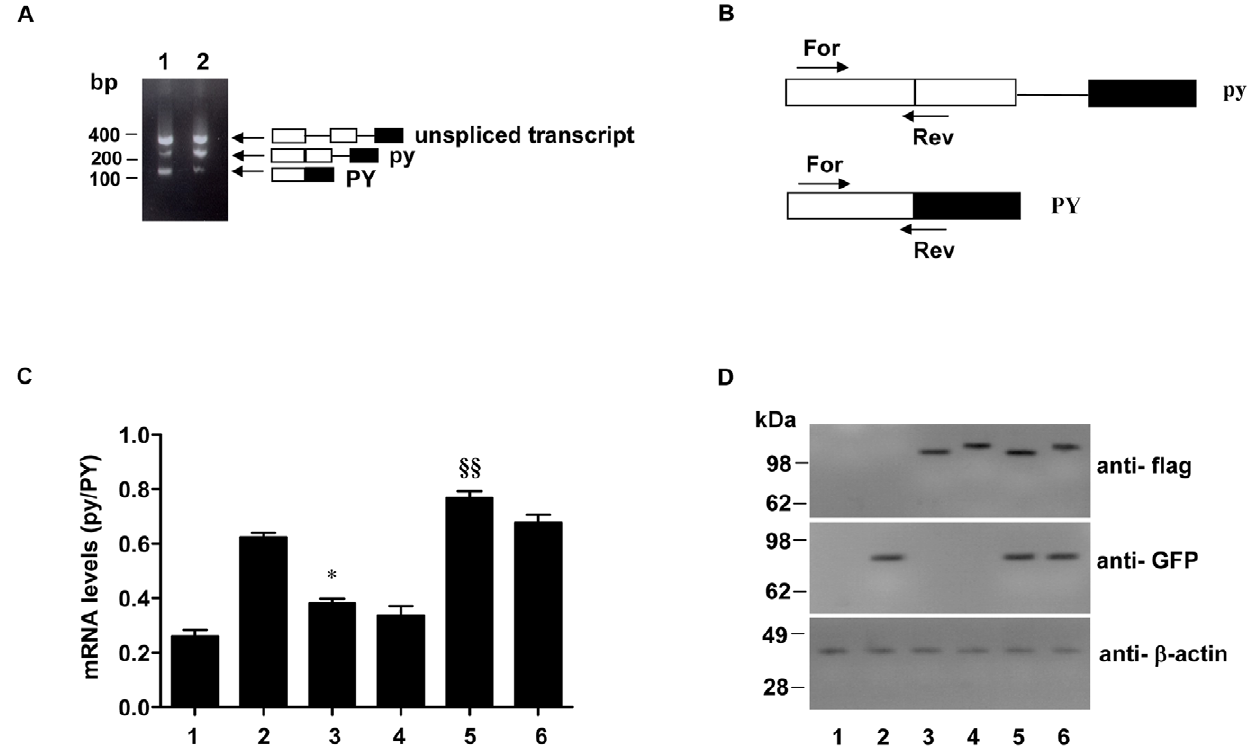
Figure 4. Effect of Atx1 overexpression on alternative splicing of pyPY. A. Alternatively spliced transcripts from cells expressing the pyPY minigene. 293T Cells were transfected with the pyPY reporter minigene plasmid. RNA was isolated 24 h post transfection and RT- PCR analysis was carried out. The predicted alternatively spliced and unspliced primary transcripts are shown on the right by diagrams in which the exons and introns are symbolised by boxes and lines, respectively. Molecular weight markers are indicated on the left. B. Schematic representation of the positions of forward (For) and reverse (Rev) primers used in Quantitative RT-PCR analysis. C. Quantitative RT-PCR analysis of the expression levels of transcripts. 293T cells were transfected with pyPY reporter minigene plasmid together with empty pCMV vector (bar 1), GFP-U2AF65 (bar 2), flag-30Q-Atx1 (bar 3), flag-82Q-Atx1 (bar 4), GFP-U2AF65 and flag-30Q-Atx1 (bar 5) or GFP-U2AF65 and flag-Atx1 82Q plasmids (bar 6). Total RNA was isolated from the cells 24 h post transfection and quantitative RT-PCR analysis using the primer sets shown in B was carried out. The histogram shows the ratios between the isoform levels (py/PY). Values are mean 6 standard deviation from four experiments. 11 indicates P , 0.01 GFP-U2AF65 and flag-30Q- Atx1 vs GFP-U2AF65 alone; * indicates P , 0.05 flag-30Q-Atx1 vs empty pCMV vector. Statistical significance was evaluated with One-way analysis of variance followed by Turkey’s Multiple Comparison Test. D. Expression of proteins in 293T cells transfected with reporter minigene, U2AF65 and Atx1 constructs. Lanes 1 to 6 correspond to bars 1 to 6 shown in C. Cell extracts were prepared 24 h after transfection and the proteins were analysed by Western blotting with indicated antibodies. Molecular weight markers are indicated on the left.